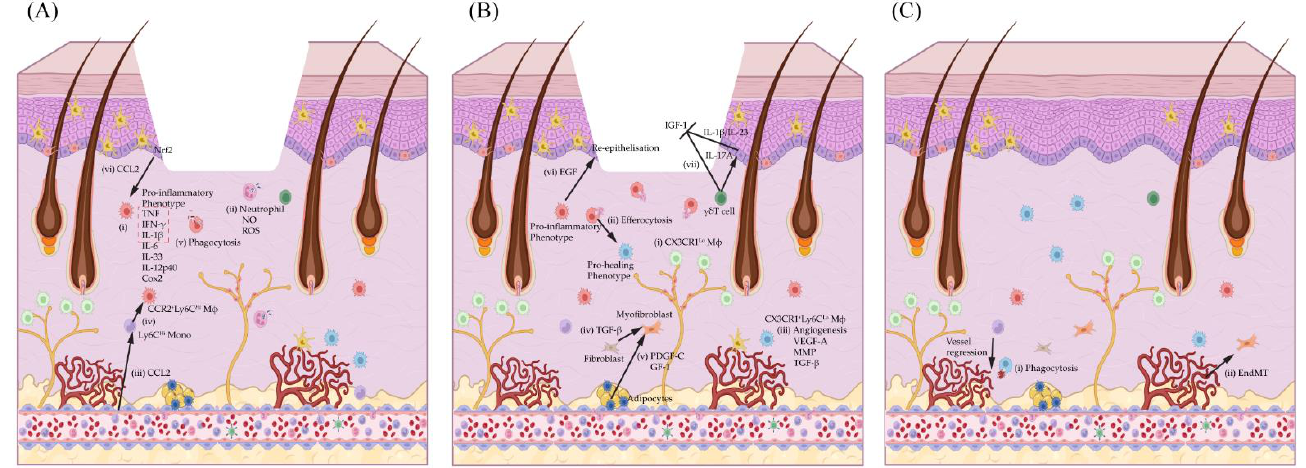
Figure 1. ( A ) Signalling crosstalk between macrophages (M φ ) with other cell types during the inflammatory phase of cutaneous wound healing. (i) Nuclear factor kappa-light-chain enhancer of activated B cells (NF- κ B) is major regulator of pro-inflammatory cytokines in macrophages (e.g., tumour necrosis factor alpha (TNF- α ), interferon (IFN)- γ and interleukin (IL)-1 β ). (ii) Neutrophils produce nitric oxide (NO) and reactive oxygen species (ROS) to prevent pathogen colonisation. (iii) (C-C motif) ligand 2 (CCL2) released by tissue-resident cells recruits Ly6C Hi monocytes into the wound during the inflammatory phase. (iv) Ly6C Hi monocytes differentiate into (C-C motif) chemokine receptor 2 (CCR2 + )Ly6C Hi M φ , releasing pro-inflammatory cytokines. (v) Macrophages help to remove pathogen via phagocytosis. (vi) Nrf2 mediates keratinocytes’ CCL2 production which is required for CCR2 + monocyte recruitment. ( B ) Signalling crosstalk between macrophages and other cell types during the proliferation phase of cutaneous wound healing. (i) (C-X3-C motif) chemokine receptor 1 (CX3CR1) Lo M φ guide nerve sprouting during wound repair and acquire high CX3CR1 expression progressively after injury. (ii) Efferocytosis of neutrophils induce macrophage anti-inflammatory phenotype switch. (iii) CX3CR1 + Ly6C Lo M φ (pro-healing phenotype) produce anti-inflammatory cytokines and growth factors, such as vascular endothelial growth factor (VEGF), matrix metalloproteinase (MMP) and transforming growth factor (TGF)- β that help to dampen inflammation and promote angiogenesis and wound contraction. (iv) TGF- β is a crucial regulator of fibroblasts/myofibroblasts. (v) Platelet-derived growth factor C (PDGF-C) and IGF-1-producing CD301b + M φ promote the proliferation of adipocyte-derived myofibroblasts during wound healing. (vi) Infiltrating F4/80 + macrophages produce epithelial growth factor (EGF) to promote keratinocyte re-epithelisation. (vii) Insulin-like growth factor 1 (IGF-1) from dendritic epidermal T cells (DETC) also helps to promote re-epithelisation, while IL-17A from γδ T cells and IL-1 β /IL23 produced by keratinocytes negatively regulate DETC IGF-1 production. ( C ) Macrophages regulate vessel regression during the remodelling phase of cutaneous wound healing. (i) Macrophages remove apoptotic endothelial cells via phagocytosis. (ii) Emerging evidence suggests that endothelial cells might undergo endothelial-to-mesenchymal transition (EndMT) during cutaneous wound